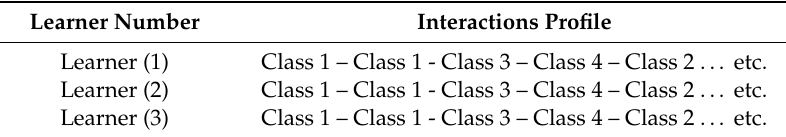
Table 2. Learners’ interactions sequence.